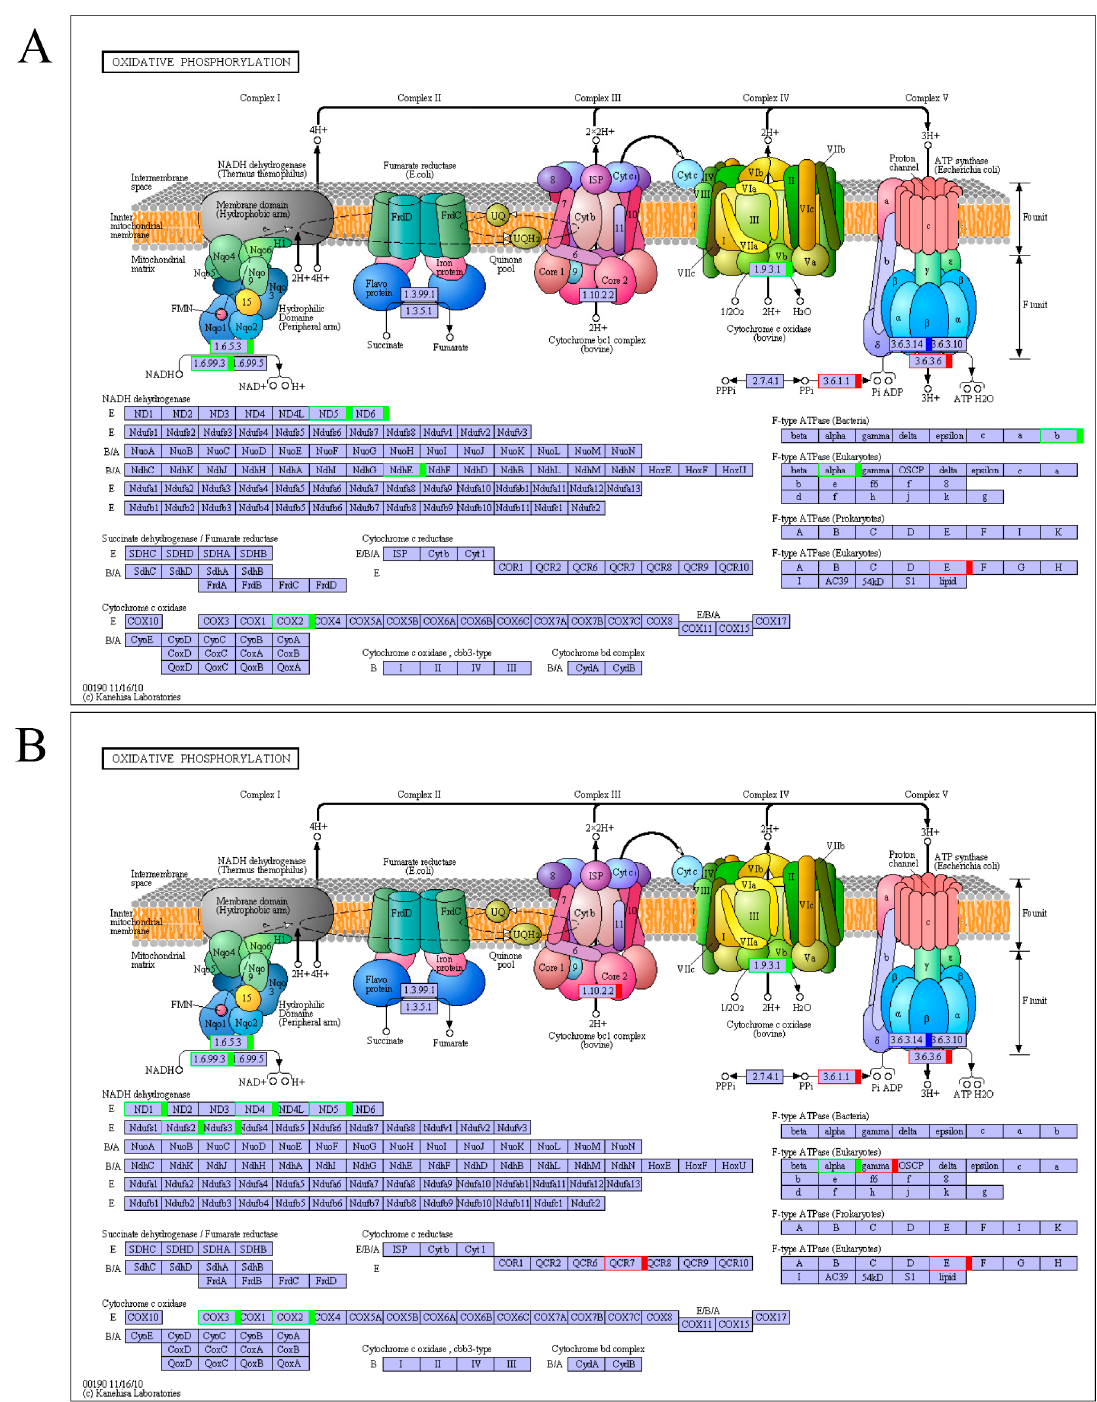
Figure 4. Welsh onion unigenes involved in oxidative phosphorylation pathways: ( A ) sequencing data from May 2013; and ( B ) sequencing data from May 2014. Blue boxes: enzymes specific to this species; Green boxes: down-regulated genes; Red boxes: up-regulated genes.